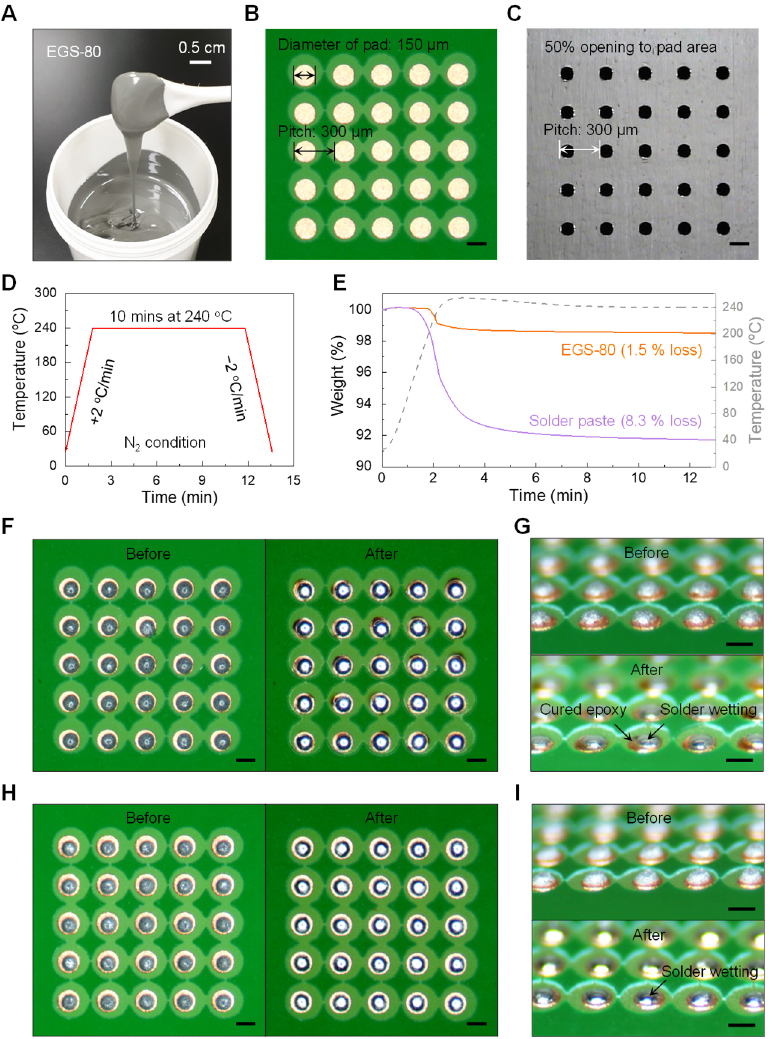
Figure 6. Potential use of EGS-80 as an epoxy-based solder paste (ESP). ( A ) Photograph of EGS-80. ( B ) Test board image with a 5 × 5 array of bare Cu pads; scale bar, 150 μ m. ( C ) Metal mask image with 50% opening to the pad area of the test board ( B ); scale bar, 150 μ m. ( D ) Thermal reflow pro- file condition. ( E ) Isothermal TGA results of EGS-80 and the solder paste at 240 °C for 10 min. The gray dashed line shows the actual temperature profile. ( F ) Top-view images of EGS-80 before (left) and after (right) the thermal reflow test ( D ); scale bar, 150 μ m. ( G ) Side-view images of EGS-80 before (top) and after (bottom) the thermal reflow test ( D ); scale bar, 150 μ m. ( H ) Top-view images of solder paste before (left) and after (right) the thermal reflow test ( D ); scale bar, 150 μ m. ( I ) Side- view images of solder paste before (top) and after (bottom) the thermal reflow test ( D ); scale bar, 150 μ m.